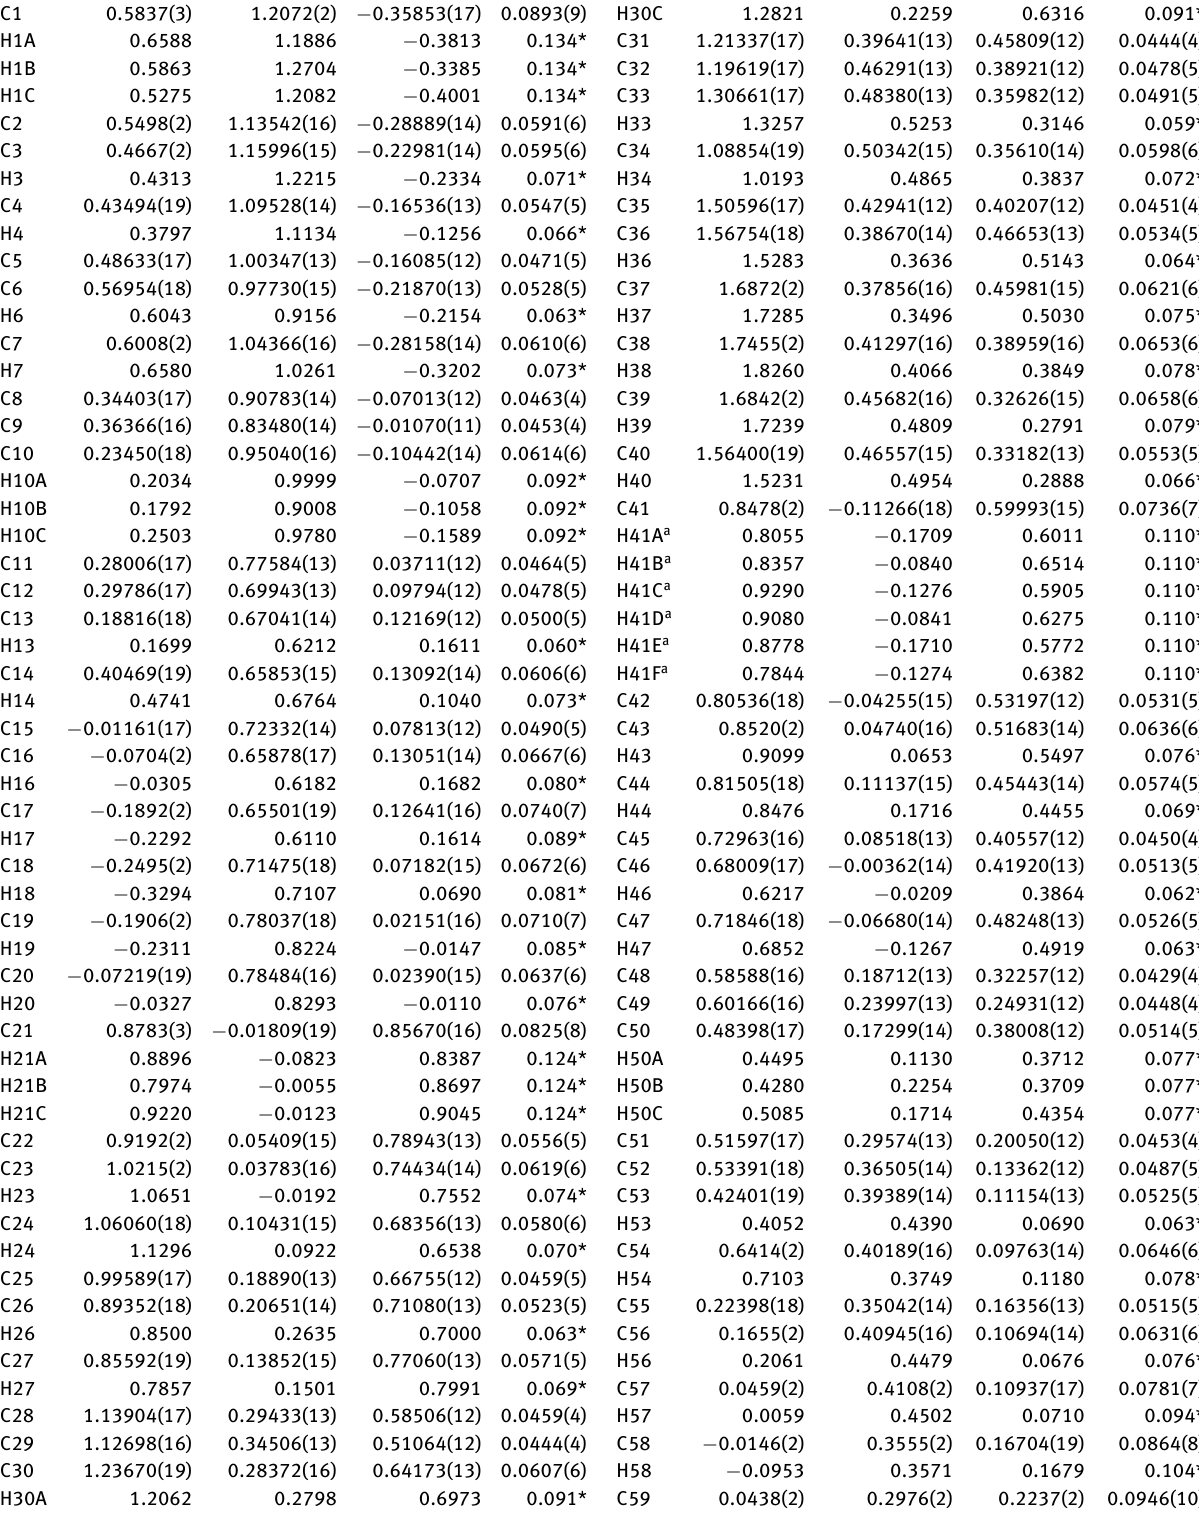
Table 2: Fractional atomic coordinates and isotropic or equivalent isotropic displacement parameters (Å 2